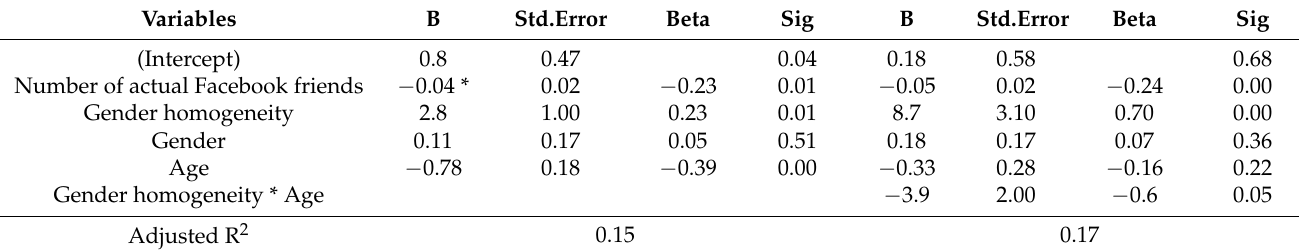
Table 3. Linear Regression model. Dependent variable: cognitive